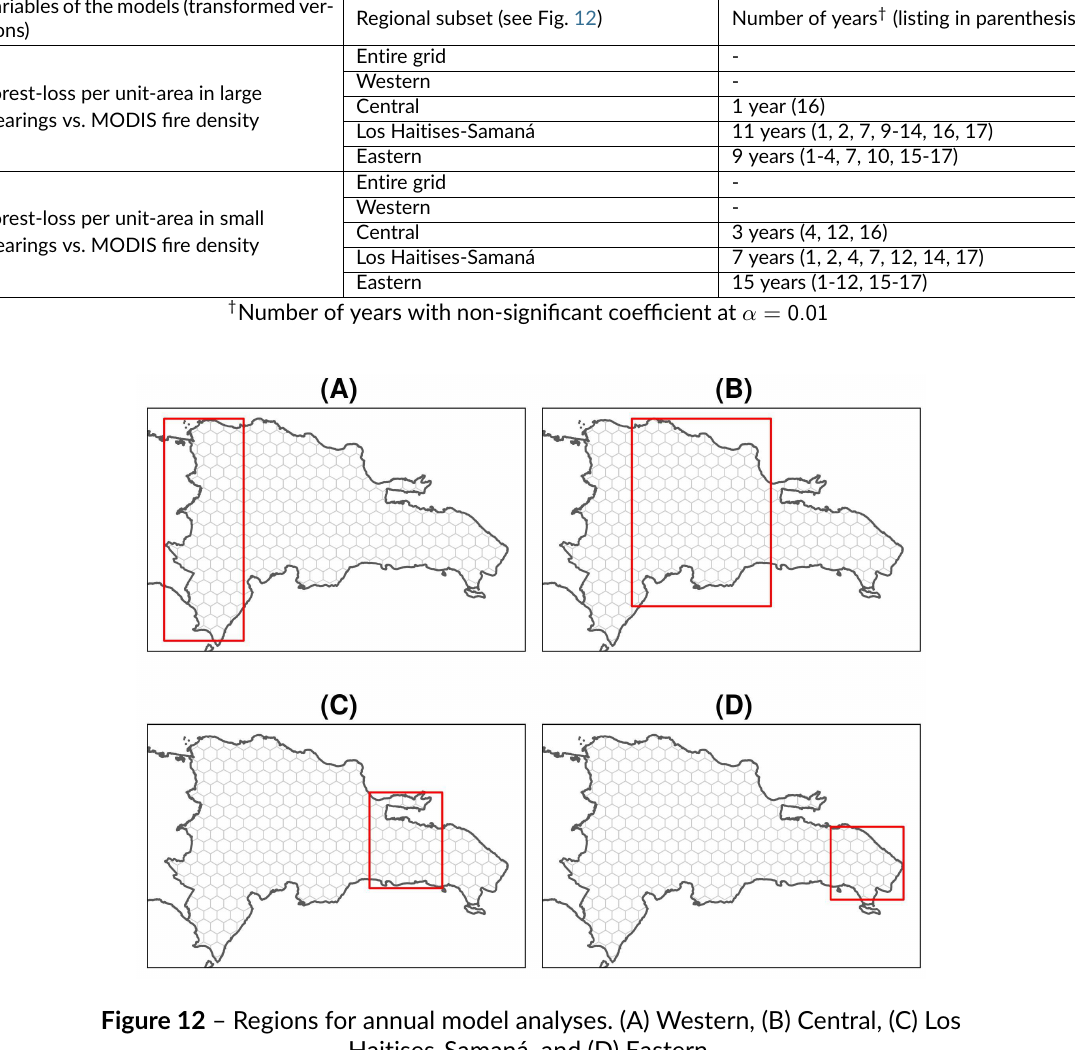
Figure 12 – Regions for annual model analyses. (A) Western, (B) Central, (C) Los Haitises-Samaná, and (D)